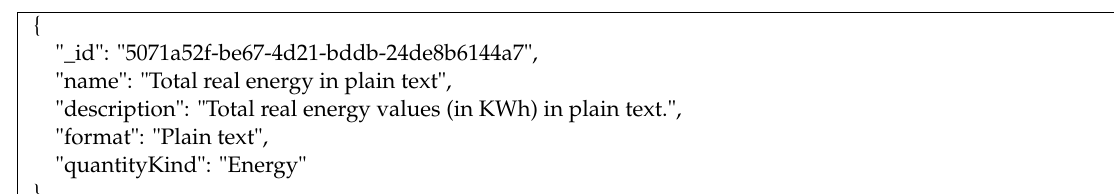
Table 3. Data Kind (DK)